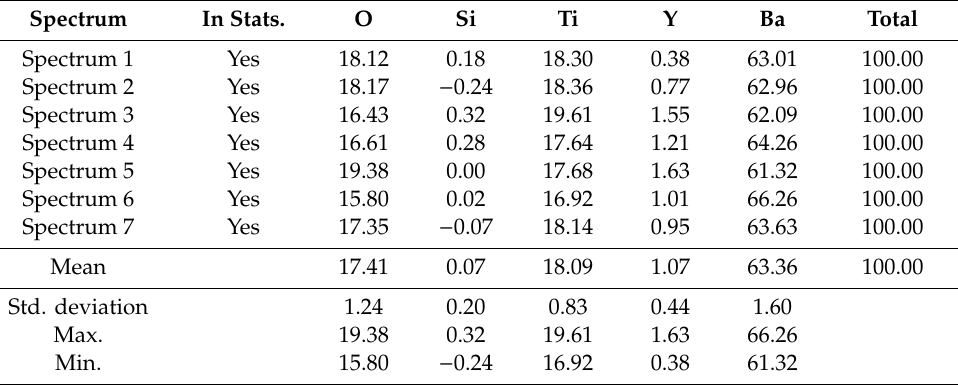
Table 1. EDX analysis of different points in KZM100-MOD-Y.